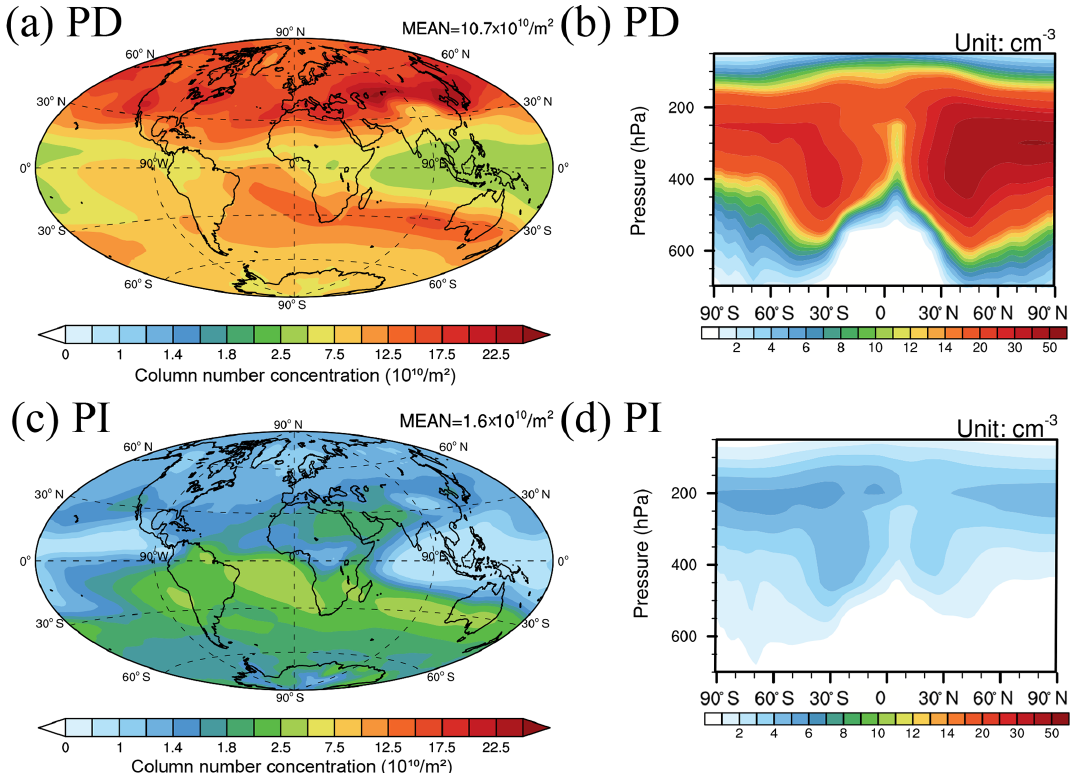
Figure 10. The vertically integrated number of INPs (a, c) and zonal average plots of INPs (b, d) from SOA in the PD_SOA (a, b) and PI_SOA (c, d)